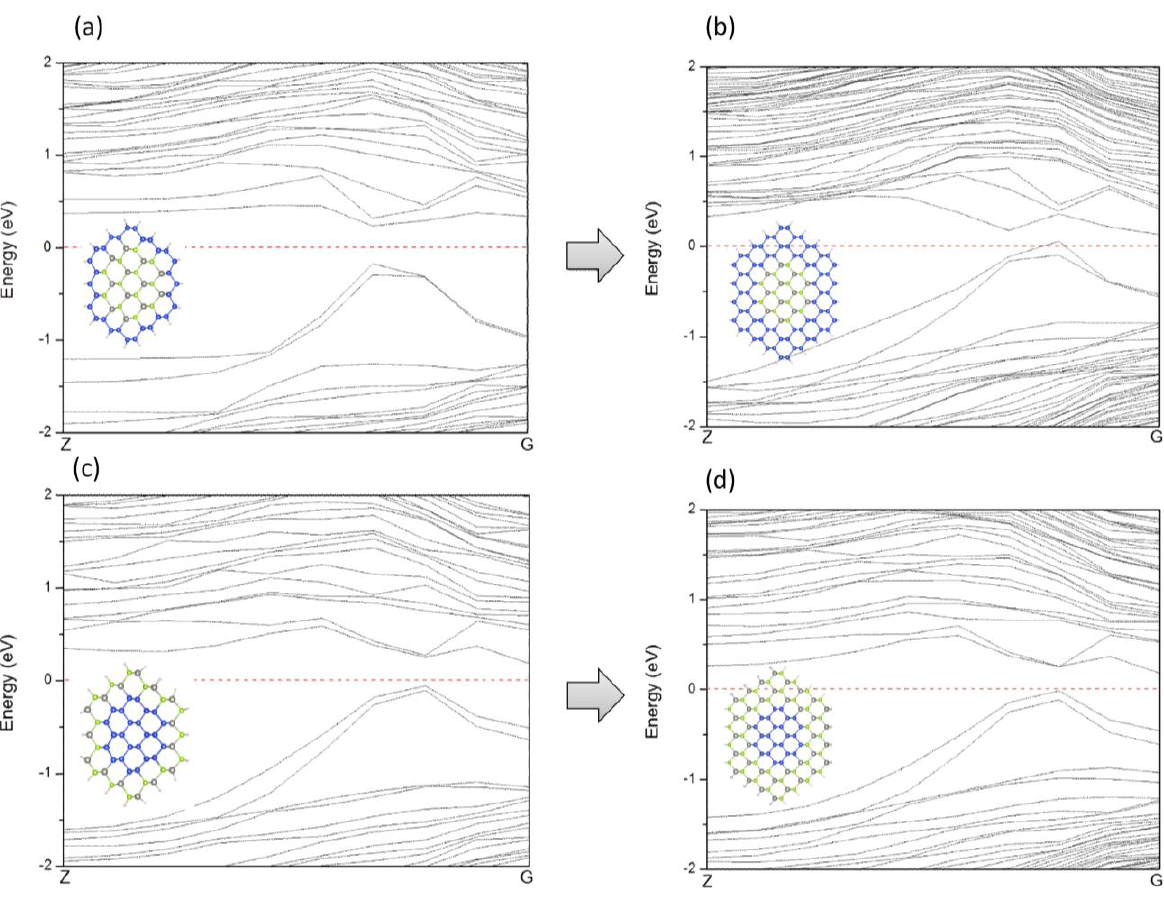
Figure 10. Variation of the band structures of ZnSe-core/Si-shell NWs ( a , b ) and Si-core/ZnSe-shell NWs ( c , d ). ( a ) ZnSe-core (2.0, 0.44); ( b ) ZnSe-core (2.8, 0.25); ( c ) Si-core (2.0, 0.44) and ( d ) Si-core (2.8,